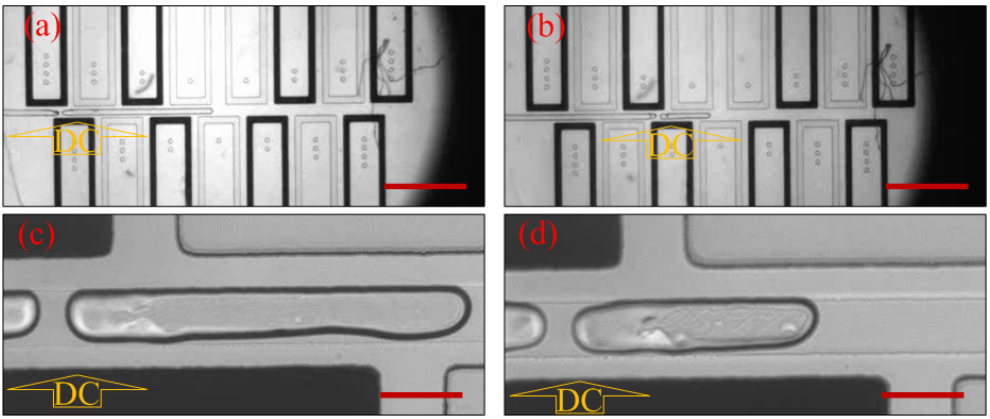
Figure 7. The droplet generation under 3000 V voltage. The scale bar in ( a ) and ( b ) is 1000 µ m; the scale bar in ( c ) and ( d ) is 100 µ m. Voltage was applied on the electrode marked as “DC”.